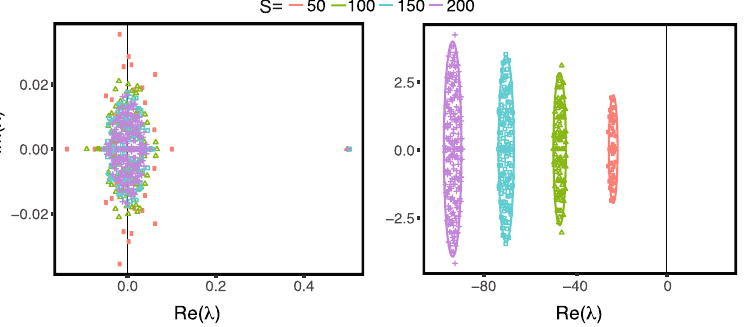
 = 1 2 = C = 0.5,  = 0.75 and  = 1. The off- L M 1 2